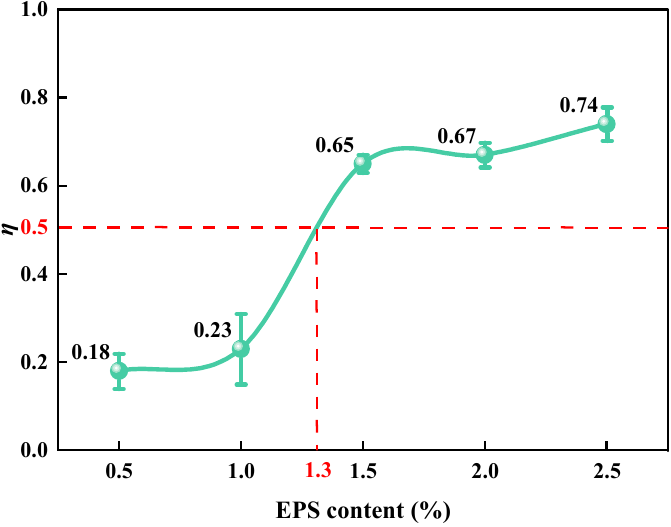
Figure 8. Relationship between EC and η .